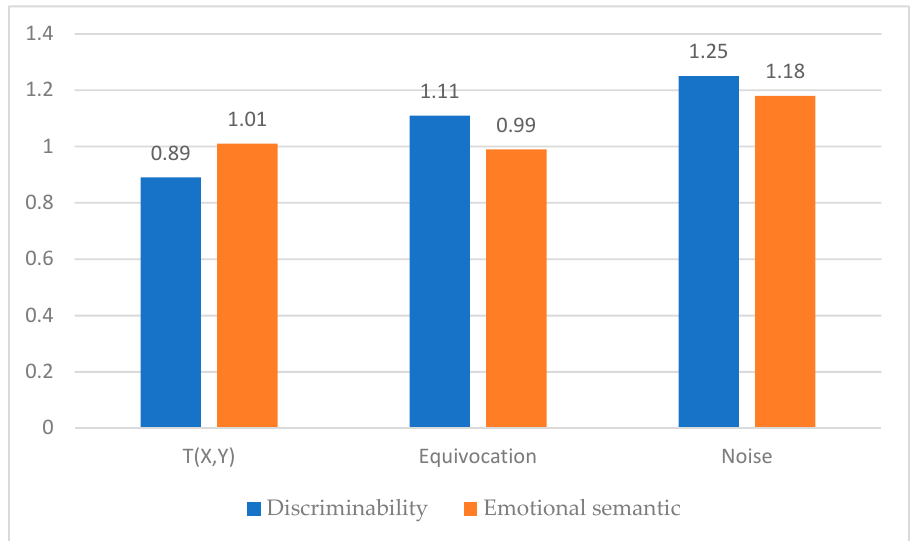
Figure 11. Differences between the two signal groups based on information theory.